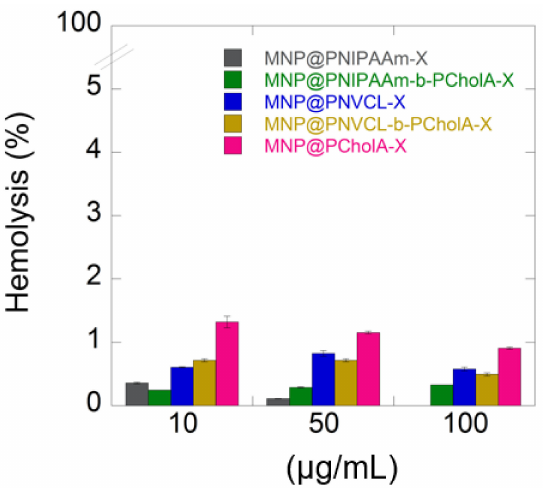
Figure 4. Hemocompatibility of polymer–iron oxide hybrids. In the next step, the potential of magnetic particles coated by polymeric shells to sensitize breast cancer cells to doxorubicin was tested. Two different breast cancer cell lines, MCF-7 and MDA-MB-231, were incubated alone, with polymer-coated particles (applied at the concentration of 10, 50, and 100 µ g/mL) or with a mixture of doxorubicin (at a constant concentration of 0.5 µ M), and with polymer-coated particles (applied at the concentration of 10, 50 and 100 µ g/mL) for 24 h. As shown in Figure 6A,B, magnetic hybrids comprising PNIPAAm or PNVCL did not induce a high toxic effect against both tested cell lines, cell viability around 80% was determined. However, the presence of poly(cholesteryl acrylate) block caused reduction in cell viability, even up to 60% at the concentration of 10 and 50 µ g/mL and around 50% for the concentration of 100 µ g/mL. Based on the results presented in Figure 6C,E, the mixtures of DOX with magnetic hybrids comprising PNIPAAm or PNVCL are characterized by relatively low toxicity against MCF- 7 cells at the doses of 10 and 50 µ g/mL. However, MNP@PNVCL- b -PCholA-X applied at the highest concentration (100 µ g/mL) caused 50% depletion of cell viability. In the case of the MDA-MB-231 cell line, the dose-dependent effect was noted (Figure 6H,J). Viability of the cancer cells after treatment with the mixtures containing the highest dose of hybrids was established at 60% and 40% for MNP@PNIPAAm-X and MNP@PNVCL-X, respectively. The presence of cholesteryl moieties significantly affected the viability of both tested cell lines. As observed in Figure 6D,F, the viability of estrogen-dependent breast cancer cells incubated with the mixture of DOX and nanohybrids at the concentrations of 50 µ g/mL and 100 µ g/mL was significantly reduced to 55% and 35% (MNP@PNIPAAm- b -PCholA- X) and to 65% and 45% (MNP@PNVCL- b -PCholA-X). In the case of the MDA-MB-231 cell line, viability was reduced to 45% for MNP@PNIPAAm- b -PCholA-X and to 40% for MNP@PNVCL- b -PCholA-X. However, the best efficacy was observed after application of DOX with hybrids comprising only the poly(cholesteryl acrylate) shell. For both tested cell lines, incubation with the mixture of DOX and MNP@PCholA-X caused depletion of viability around 40%, even at the concentration of 50 µ